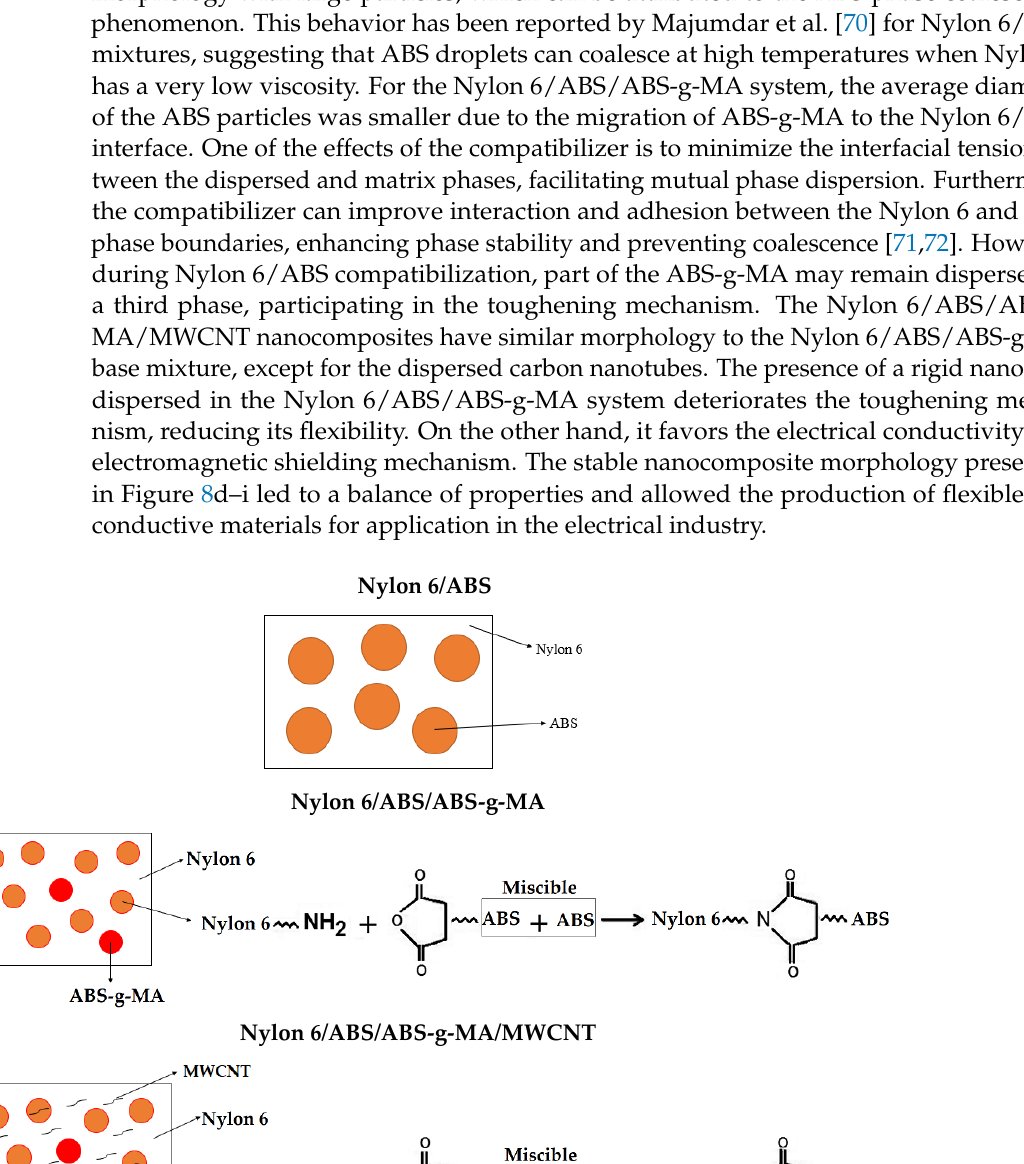
13 of 24 Figure 8. SEM micrographs of the impact test fracture surface: ( a ) Nylon 6 (2000×); ( b ) Nylon 6/ABS (2000×); ( c ) Nylon 6/ABS/ABS-g-MA (2000×); ( d , e ) Nylon 6/ABS/ABS-g-MA/MWCNT (1 phr) (2000× and 10,000×); ( f , g ) Nylon 6/ABS/ABS-g-MA/MWCNT (3 phr) (2000× and 10,000×); ( h , i ) Nylon